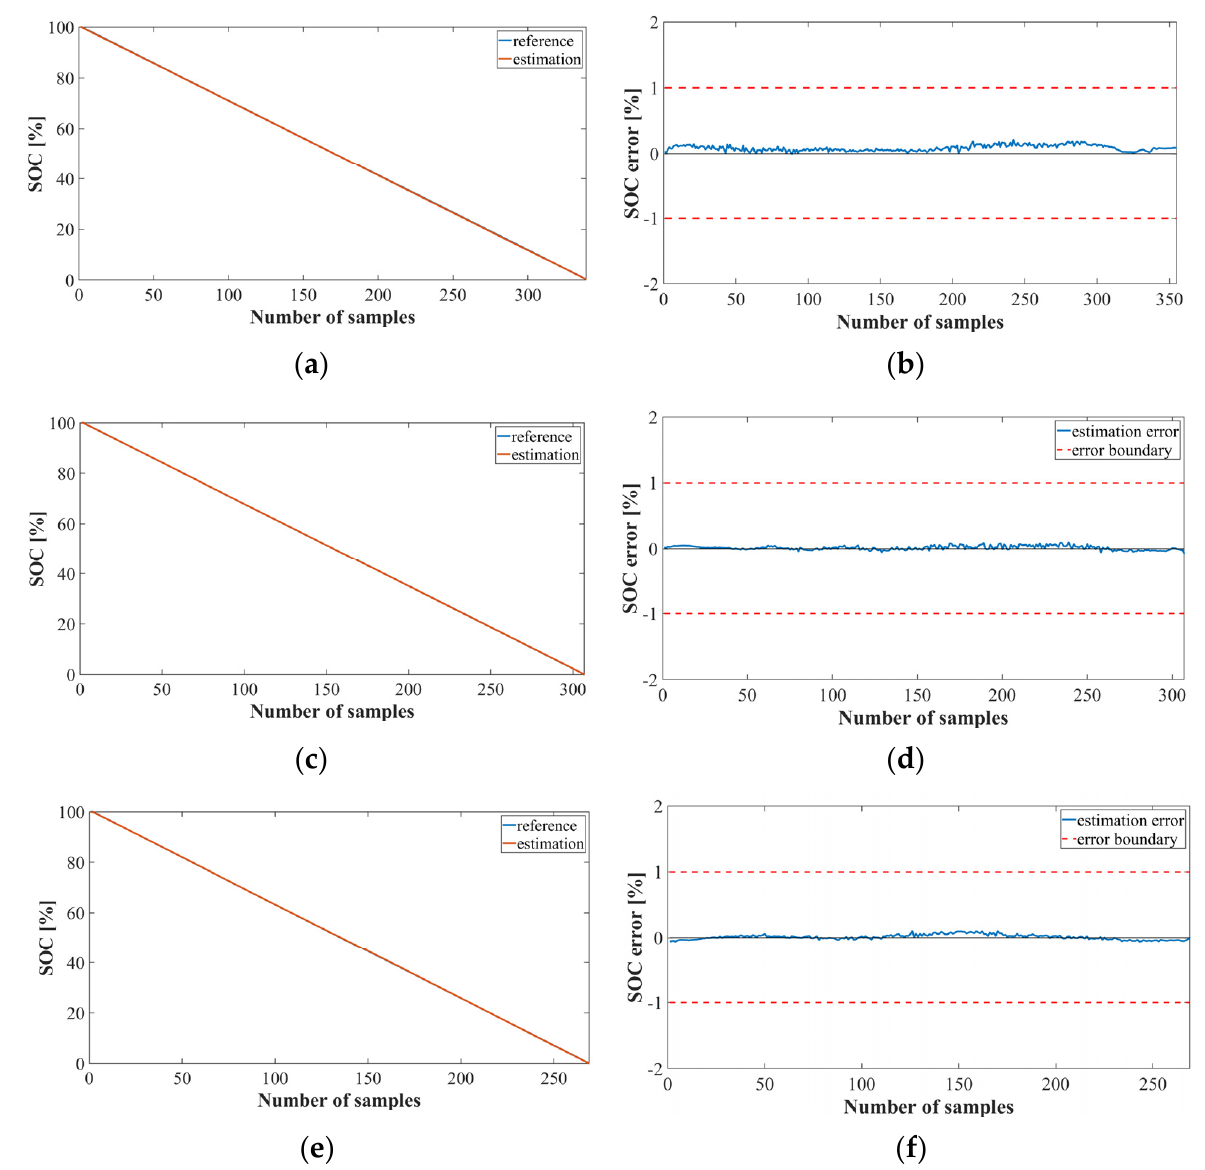
Figure 8. SOC estimation results for Method 2 using the LSTM (NASA dataset): ( a ) SOC estimation result; ( b ) error at cycle 41; ( c ) SOC estimation result; ( d ) error at cycle 78; ( e ) SOC estimation result; ( f ) error at cycle 125.